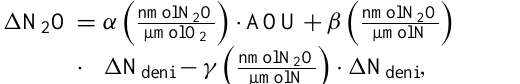
(Fig. S1). The use of a simple tri-linear 1 N 2 O / O 2